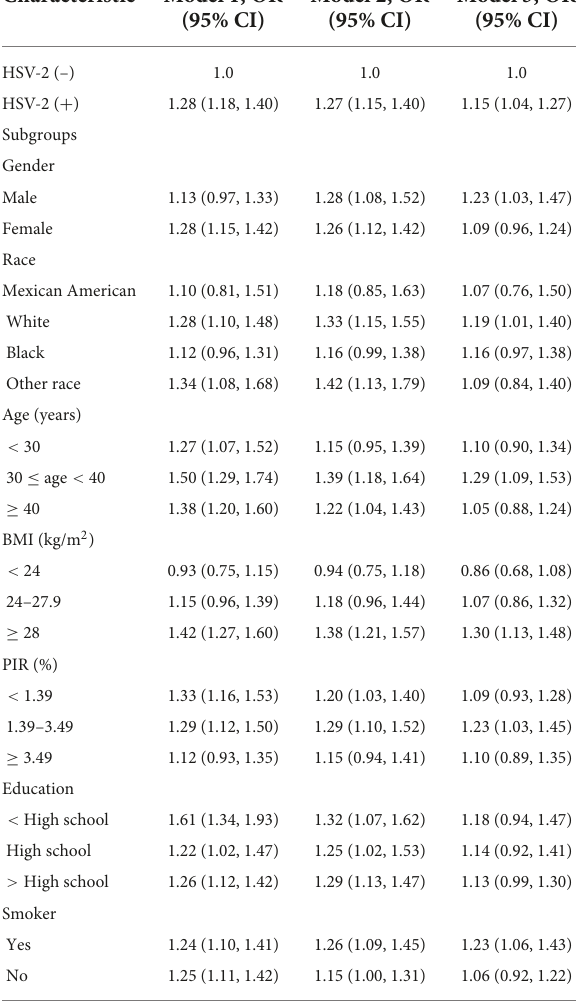
Model1:Nocovariateswereadjusted. Model2:Age,gender,racewereadjusted. Model3:Age,gender,race,bodymassindex,povertytoincomeratio,education,marital status, family members, smoker, alcohol drinking, sexual intercourse, used injecting drugs,closerelativeswithasthmawereadjusted. The model is not adjusted for the stratification variable itself in the subgroup analysis. HSV-2,Herpessimplexvirustype2;BMI,Bodymassindex(kg/m 2 );PIR,Ratiooffamily